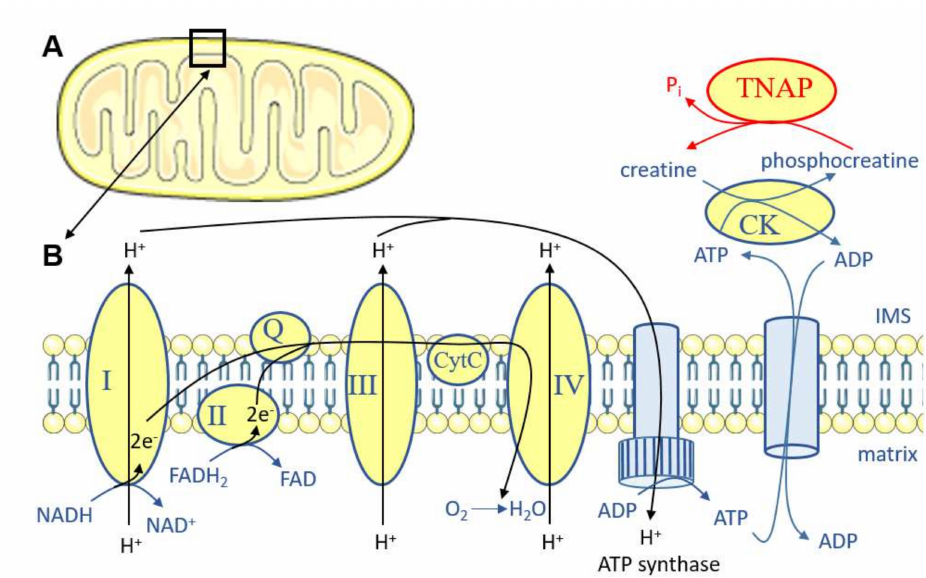
Figure 5. Schematic representation of the mitochondrial electron transport chain showing TNAP’s involvement in the futile creatine cycle. ( A ) indicates that the molecules and reactions presented in ( B ) are present at the inner mitochondrial membrane, in the intermembrane space, and possibly in the cytoplasm (it is still obscure where exactly TNAP may dephosphorylate phosphocreatine). I to IV represent complex I to complex IV. CK: creatine kinase; CytC: cytochrome C; FAD: flavine adenine dinucleotide; IMS: intermembrane space; NAD: nicotinamide adenine dinucleotide; Q: coenzyme